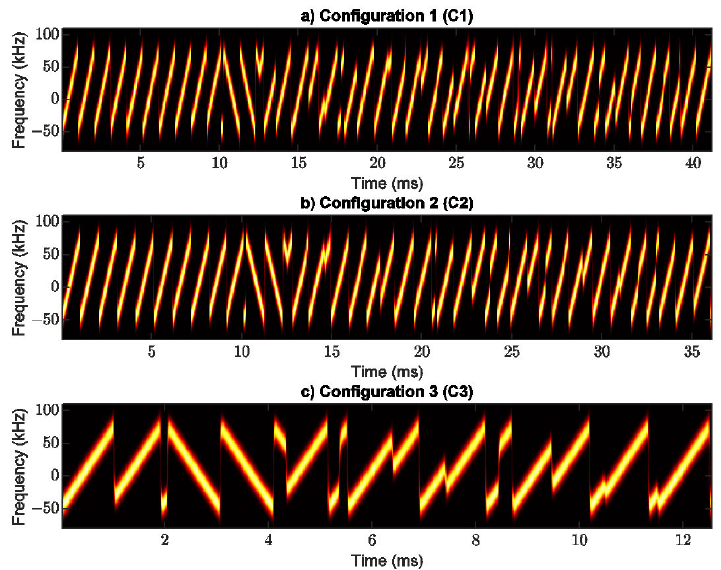
Figure 5. LoRa PHY structure: ( a ) with CRC enabled, header enabled, and programmed preamble of eight symbols, ( b ) with CRC disabled, header disabled and preamble of eight symbols, and ( c ) with CRC disabled, header disabled and without